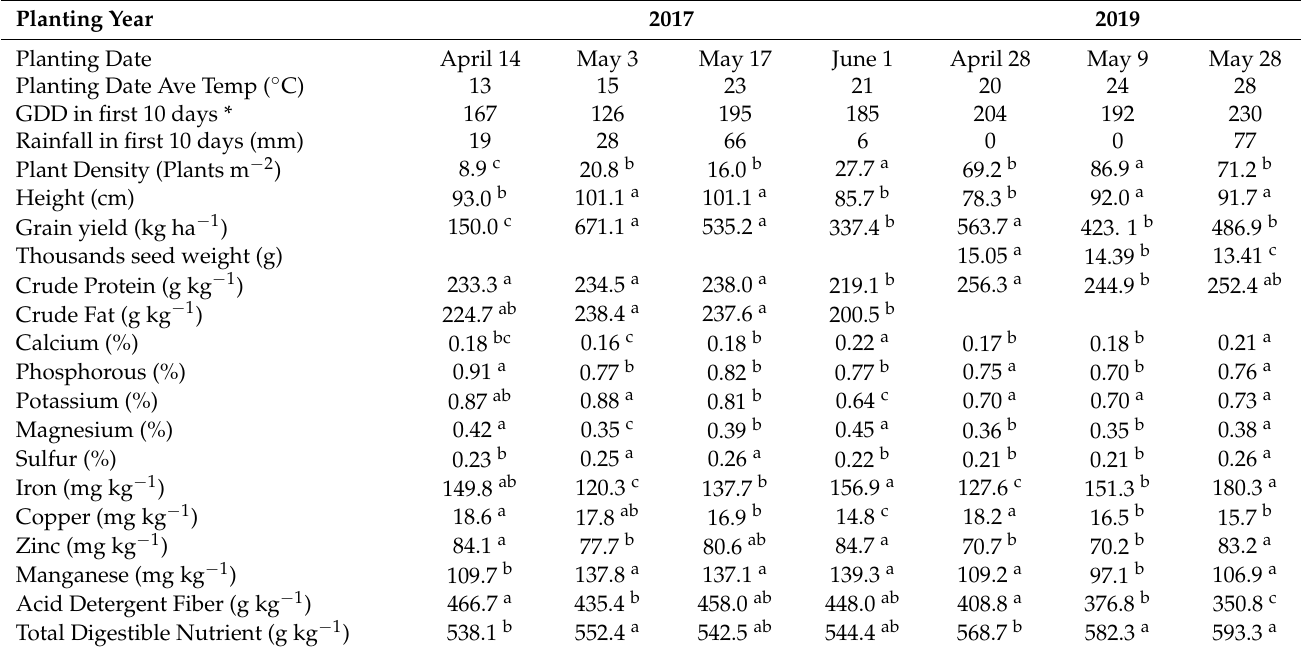
Table 4. Comparison of selected characteristics of grain hemp cultivars as affected by planting date. Values are calculated means of different